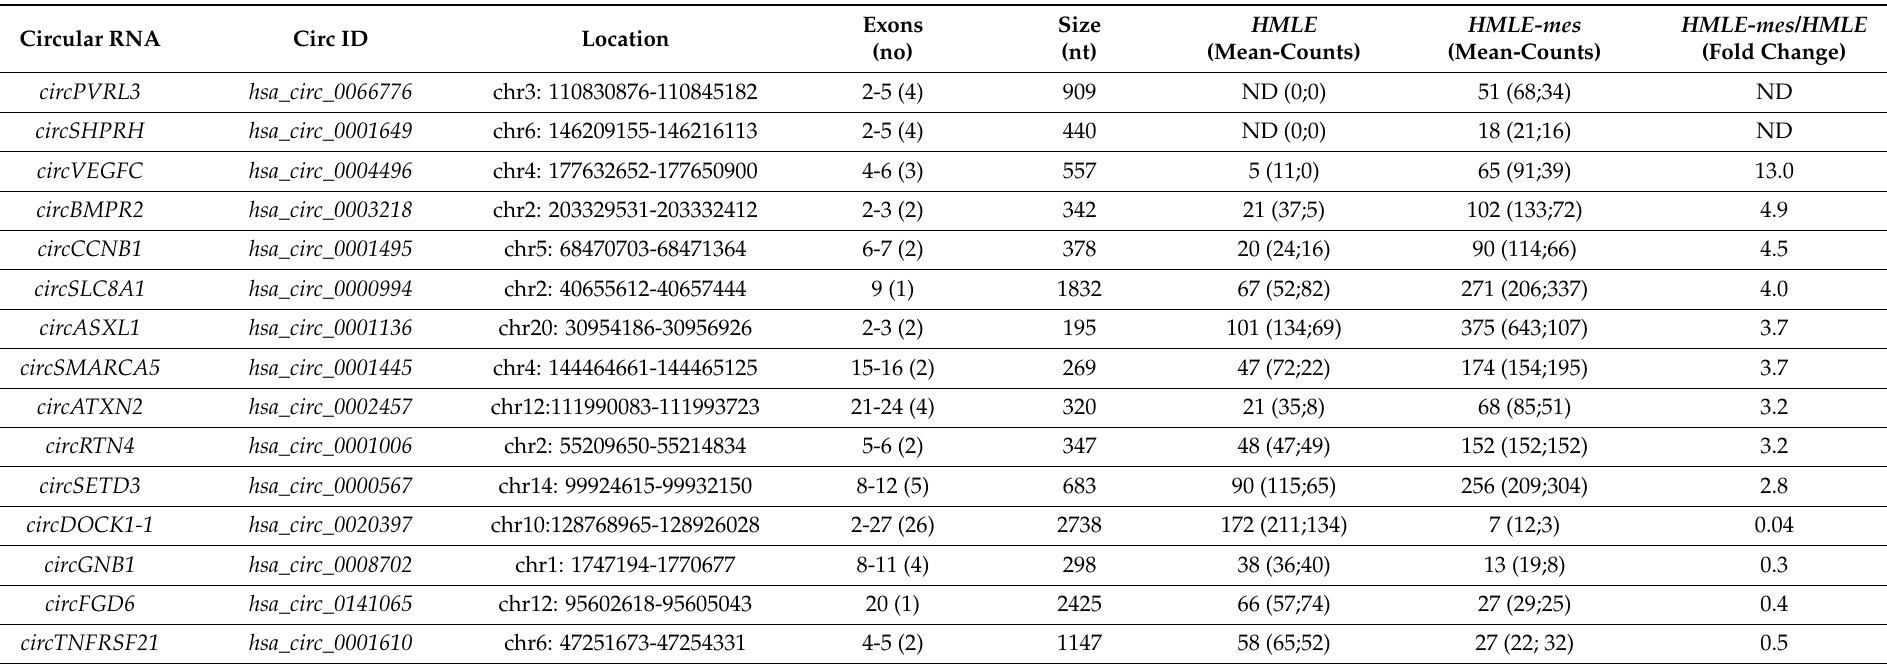
Table 1. Differential expression of specific circRNA in mammary gland epithelial cells following EMT. The expression of the indicated circRNA was determined after RNA-seq analysis of total RNA extracted from the human mammary gland epithelial cell line, control HMLE cells, and HMLE cells exposed to TGF β ( HMLE-mes ) to induce EMT (epithelial-to-mesenchymal transition). The results are expressed as the mean counts determined in 2 independent samples as shown. The identification codes and the structural characteristics of the indicated circRNAs were obtained from the circBASE website (http://www.circbase.org/, accessed on 12 May 2021). Circular